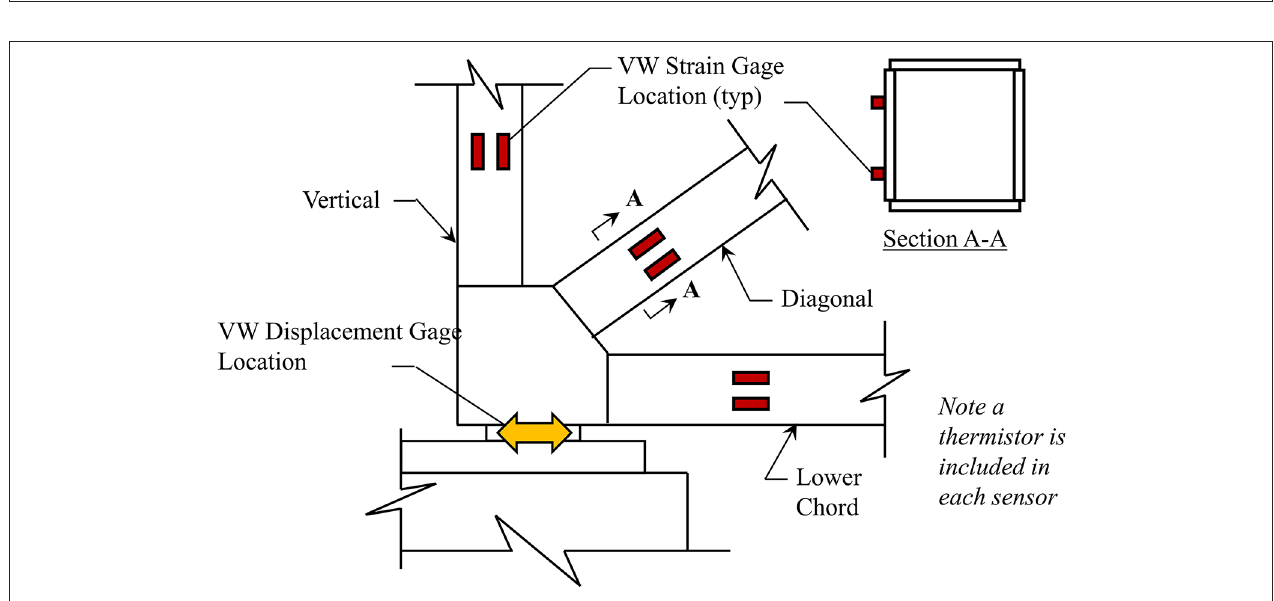
FIGURE 5 | Hernando Desoto (HD) bridge main spans (with Pier labels).